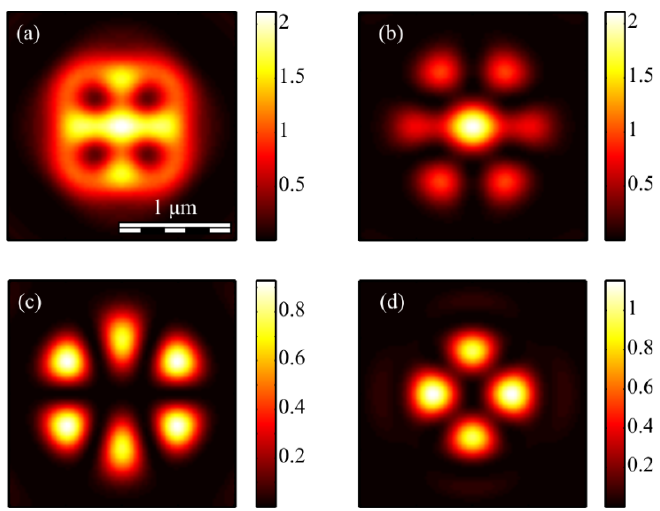
Figure 6. The intensity I ( a ) and its components I x ( b ), I y ( c ) I z ( d ) of the focused vector field (1) of the second ( m = 3) order with a = 1.